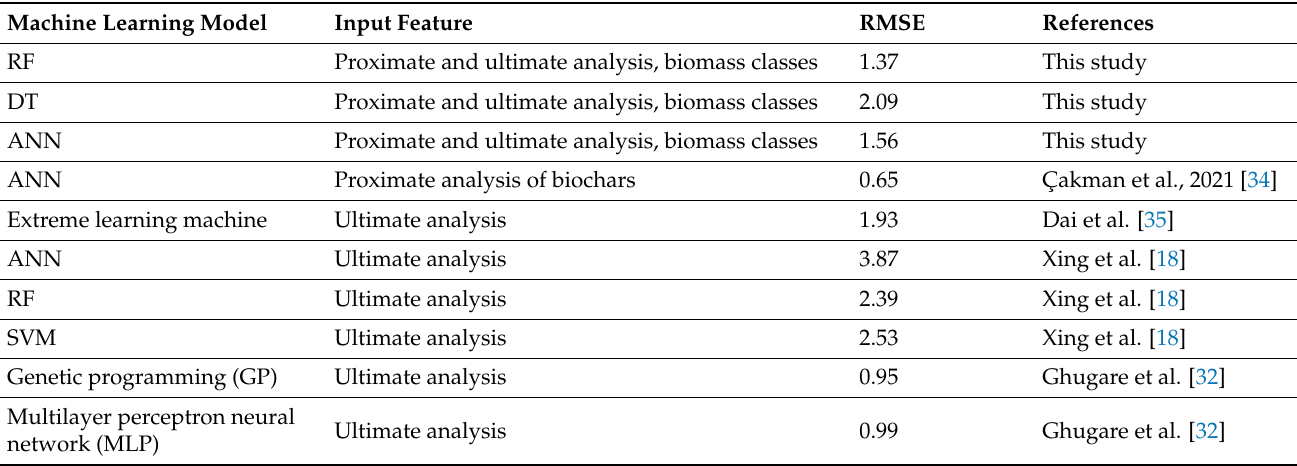
Table 3. Comparison of statistical measurement criteria with ML-based HHV values reported in the literature.